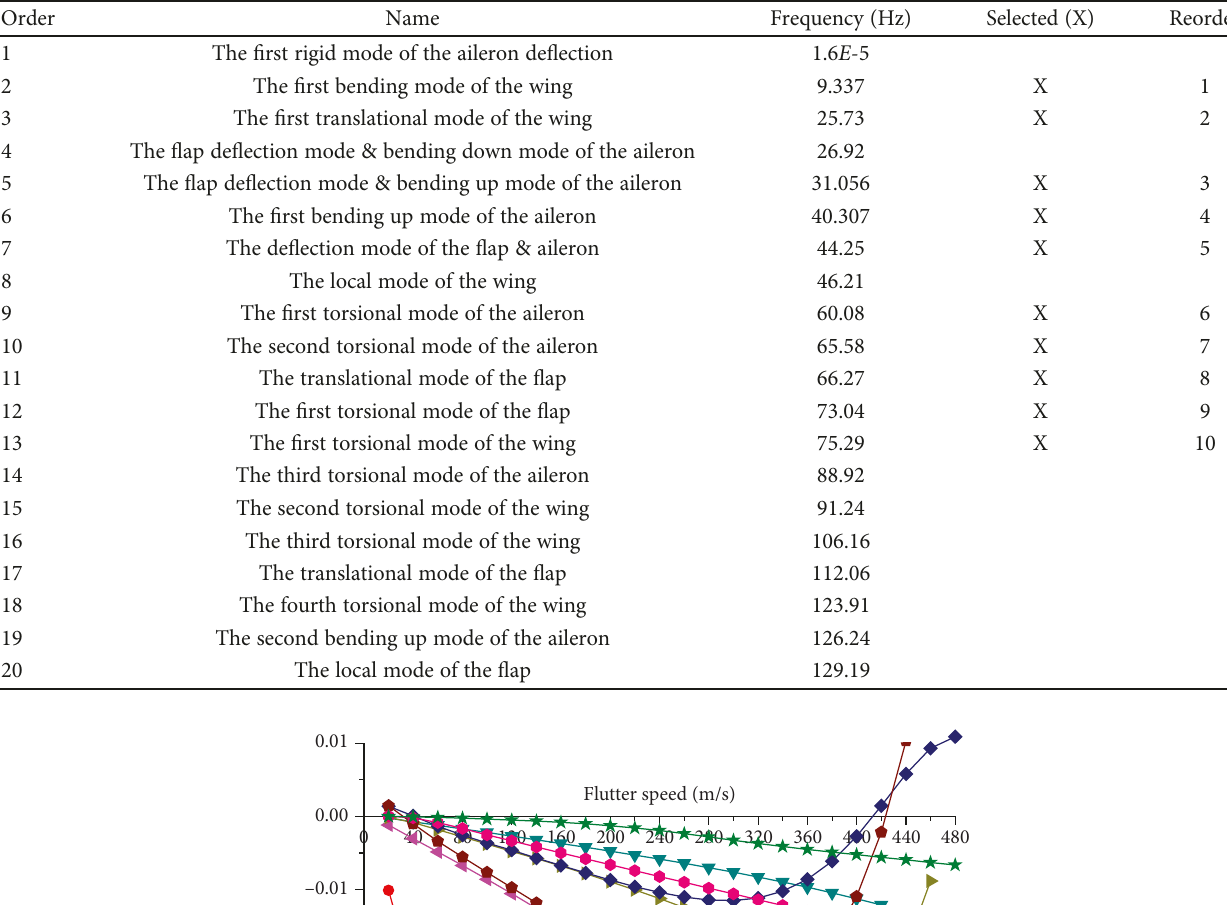
Table 5: Ten selected modes for fl utter.